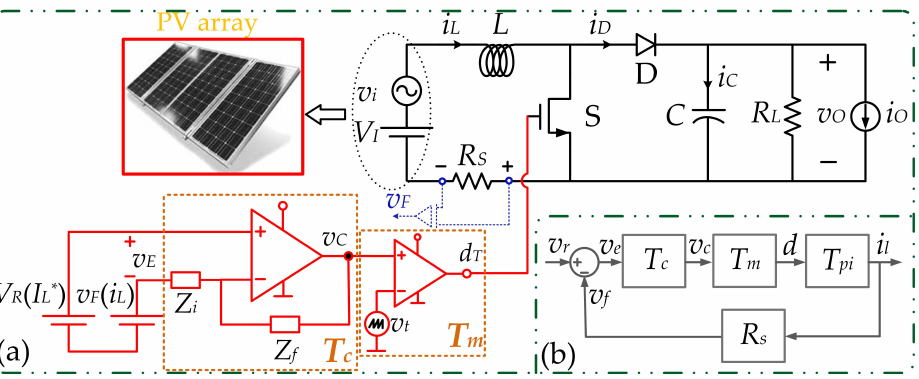
Figure 2. The PV-connected DC–DC boost converter: ( a ) power and control circuits and ( b ) small- signal block diagram representation assuming that i O = v i = 0. Table 1. Specifications of the BP Solar BP4170B module.